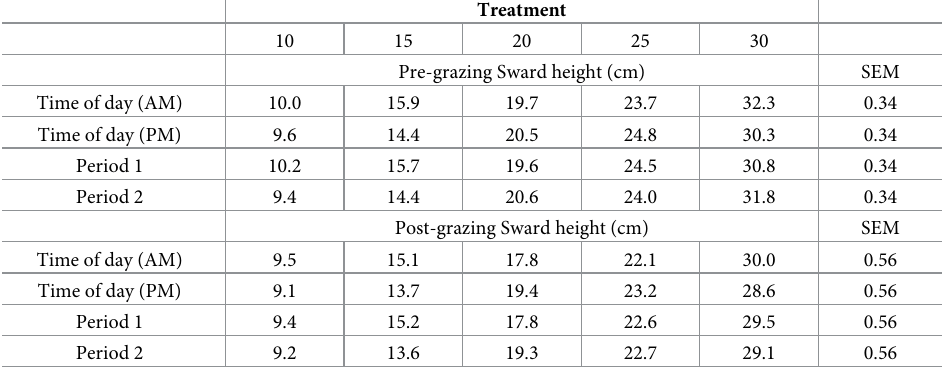
The times of the day AM and PM correspond to the morning and afternoon assessment respectively. SEM: Standard error of the